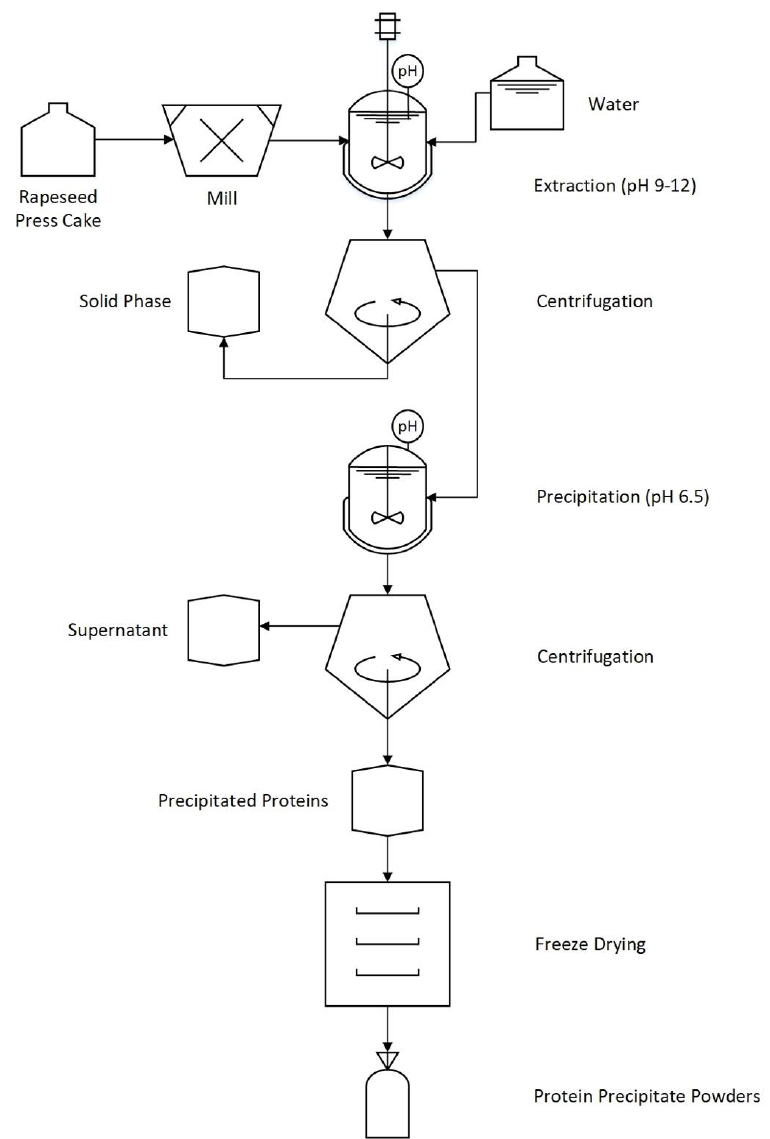
Figure 2. Schematic illustration of the rapeseed protein extraction process.